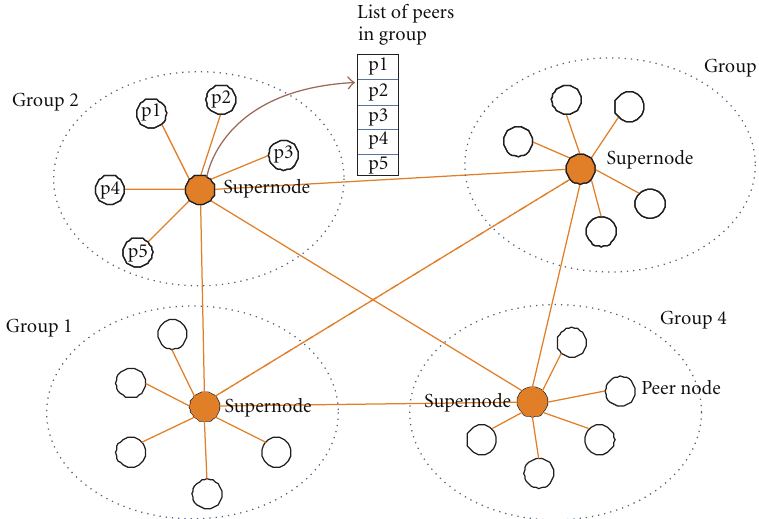
Figure 2: Two-tier hierarchy